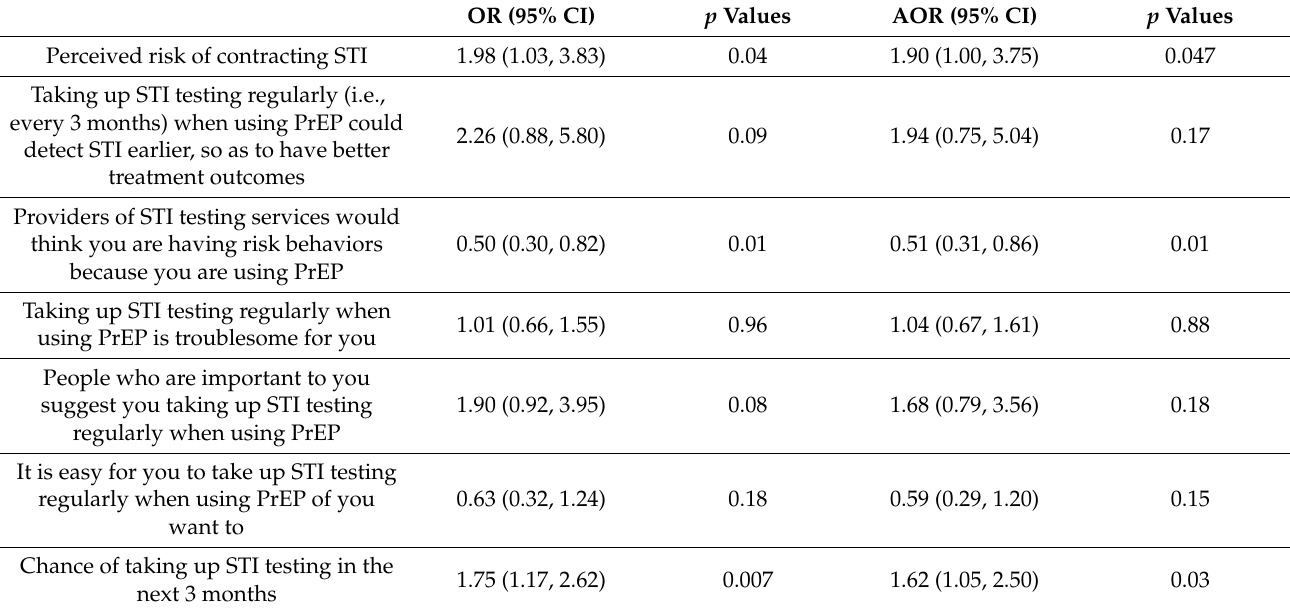
Table 4. Associations between perceptions related to STI testing and STI testing uptake during the follow-up period (among participants being followed up at Month 3, n =